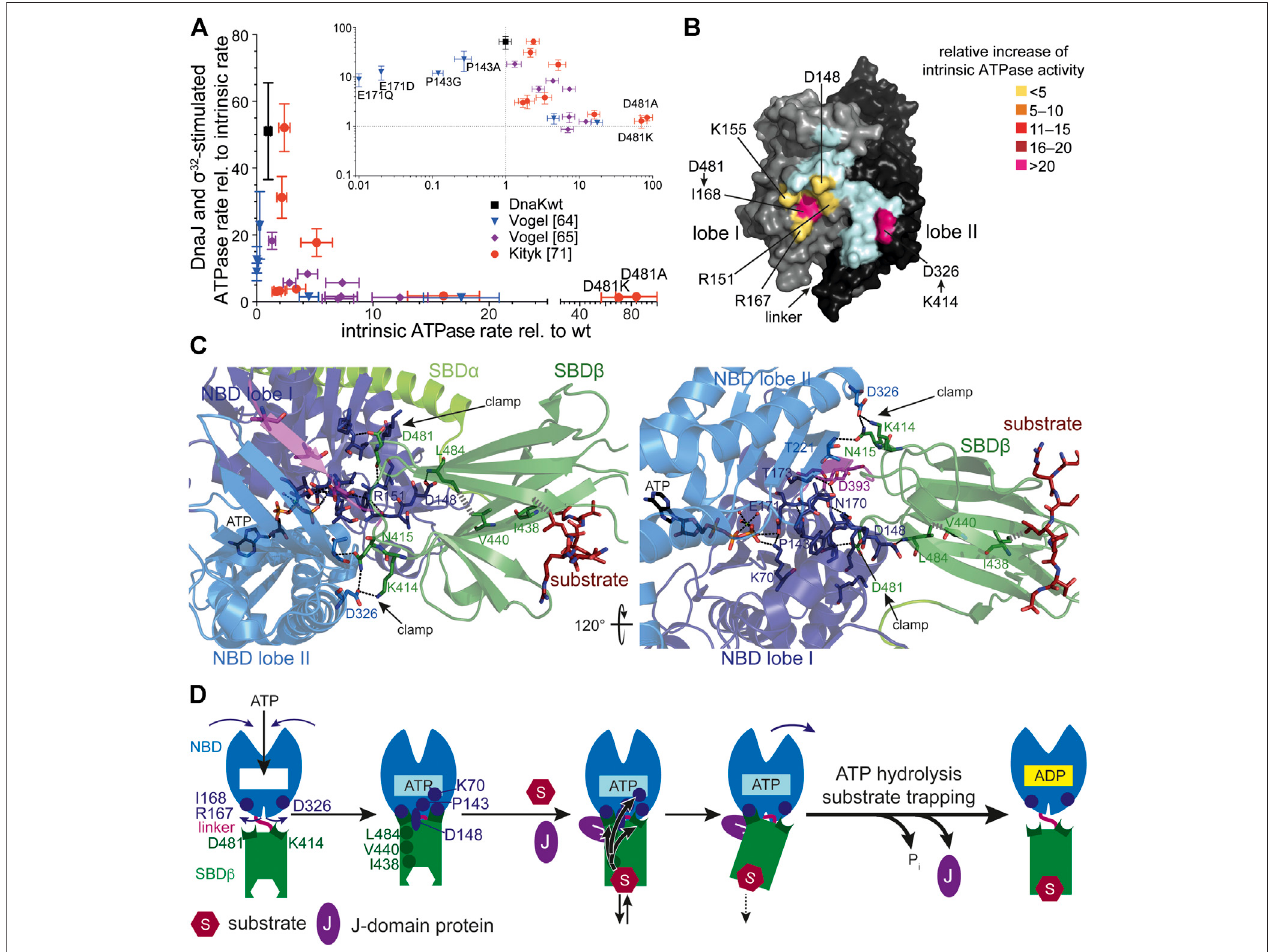
FIGURE 3 | Allostery in Hsp70s. (A) , Amino acid replacements outside the catalytic pocket that impair interdomain communication increase the intrinsic ATPase rate. A signature for allosteric pro fi ciency of DnaK variants is the synergistic stimulation of DnaK ’ s ATPase rate by DnaJ and its protein client σ 32 . Thus, single turnover ATPase ratesofwildtypeandmutantDnaKproteinsinthepresenceof50 nMDnaJand1 µM σ 32 isplottedvs.theirintrinsicATPaserate.Defectsinallosteryreducethe DnaJ- σ 32 -stimulated ATPase rate. Inset, same data on logarithmic scales. Data taken from (Vogel et al., 2006a; Vogel et al., 2006b; Kityk et al., 2015). (B) , Surface representation of the NBD of DnaK in the ATP-bound state (4B9Q) with lobe I and lobe II colored in gray and black, respectively, and the interface to which the SBD β docksinlightcyan,exceptfortheindicatedresiduesknowntobeinvolvedinallosterythemselvesorcontactedbyresiduesoftheSBD β knowntobeinvolvedinallostery. Thesearecoloredaccordingto therelative increaseofintrinsic ATPase activity when these residues arereplacedthemselvesby alanine or iftheirpendantin theSBD β is replaced byalanine (D481A) or isoleucine (K414I) [modi fi ed from (Mayer, 2018)]. (C) ,Intramolecular pathways of allostery.Polar (black dashed lines) and non-polar (gray hatched lines) interactions from the substrate to the catalytic center for ATP hydrolysis. Indicated are contacts (D481 → I168 and K414 → D326, N415 → T221) that fi x the NBDlobesintherotated,ATPhydrolysis-incompetentstate(clamp)(Kityketal.,2015).Rightpanelrotateby120 ° ascompared totheleftpanelasindicated.Thecentral leucin of the substrate peptide forms hydrophobic contacts with I438 on β -strand 4. This interaction is transmitted to V440 on strand four and further, through hydrophobicinteractions,toL484on β -strand6.L484formshydrogenbondinteractionswithD148thatisconnectedthrougharigidloopwithP143.P143contactsK70 that forms a hydrogen bond with the γ -phosphate of ATP and stabilizes the transition state of hydrolysis. In this way binding of substrates is directly transmitted into